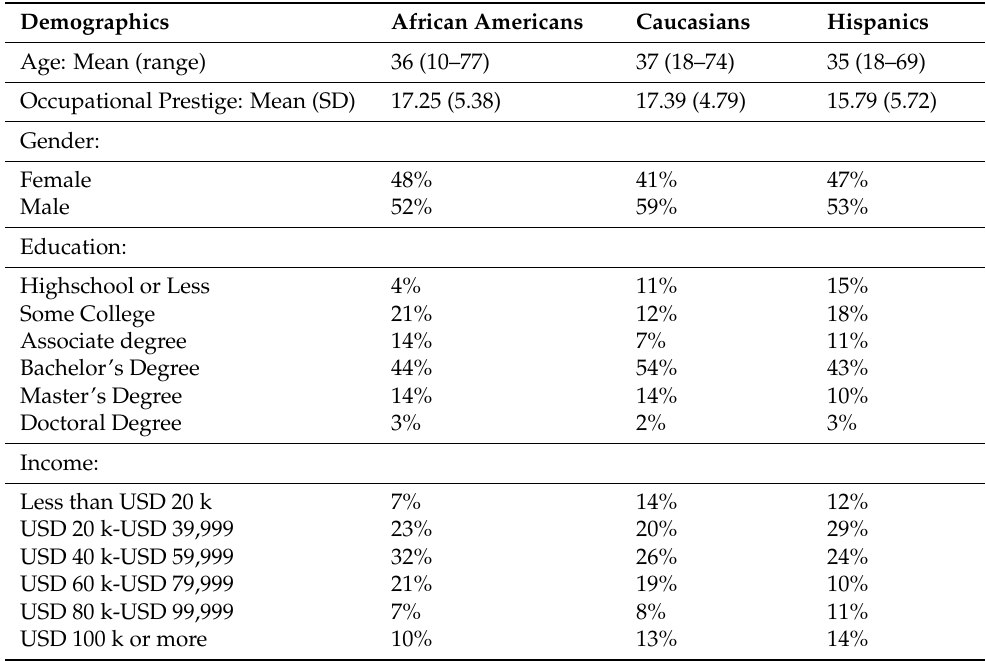
Table 1. Demographics across Ethnic